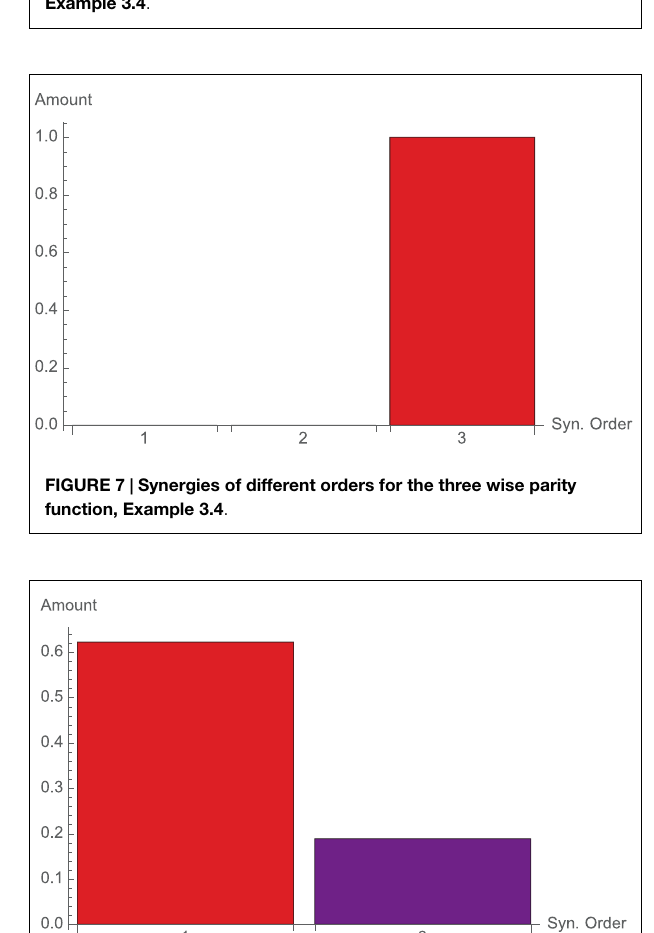
FIGURE 6 | Synergies of different orders for the binary XOR function, Example 3.4 .